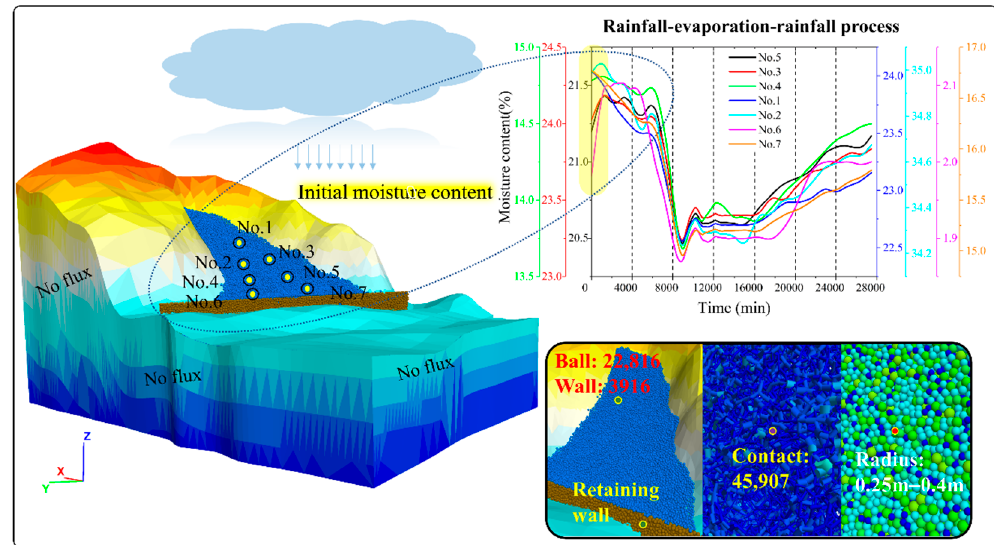
Figure 4. Slope model composition and initial boundary condition setting.